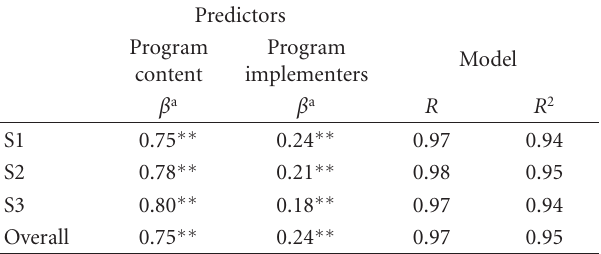
Table 8: Multiple regression analyses predicting program e ff ective-